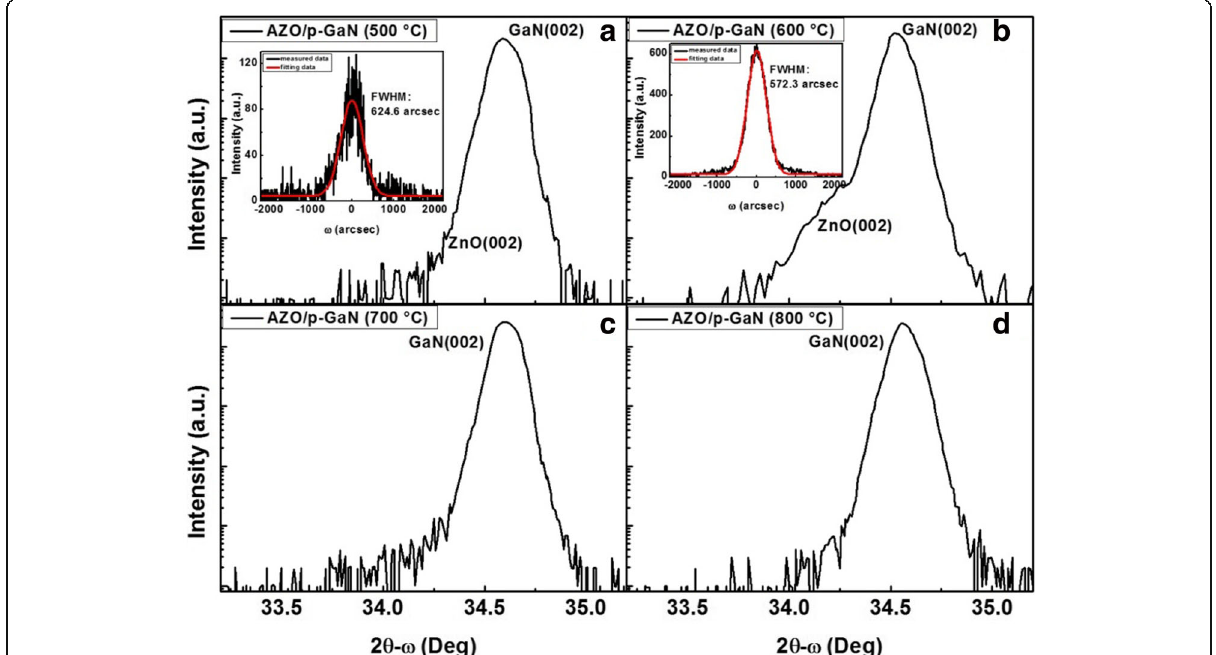
Fig. 1 X-ray diffraction spectra of AZO films deposited directly on p-GaN substrate by PAD method in different temperature. a 500 °C; b 600 °C; c 700 °C and d 800 °C. The inner graphs of ( a ) and ( b ) show the rocking curve of the 002 diffraction peak of AZO